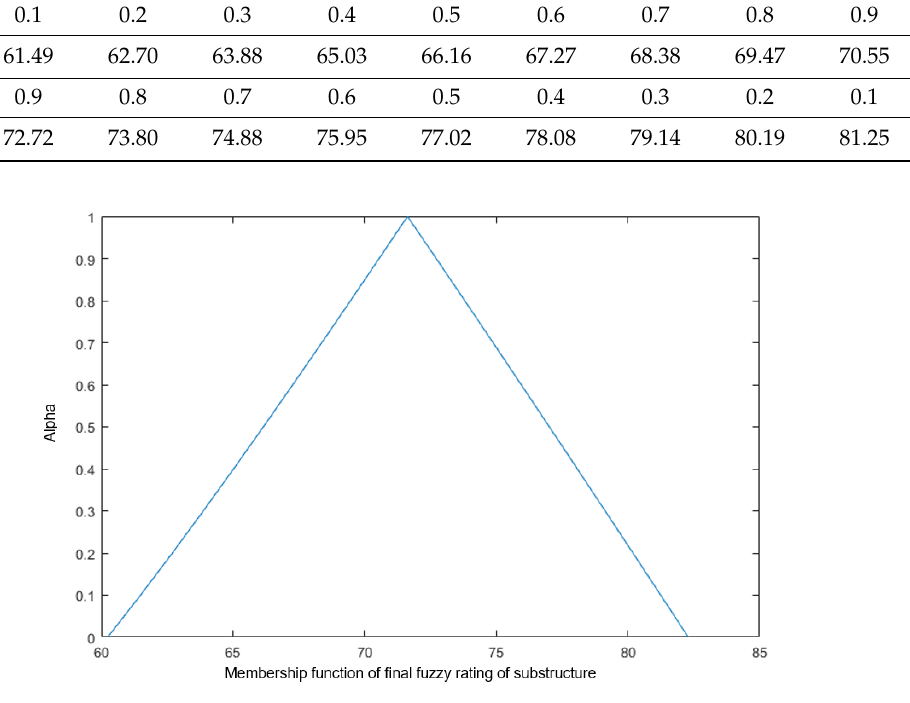
Figure 9. Graphical representation of the membership function of substructure component final rating for all combinations.